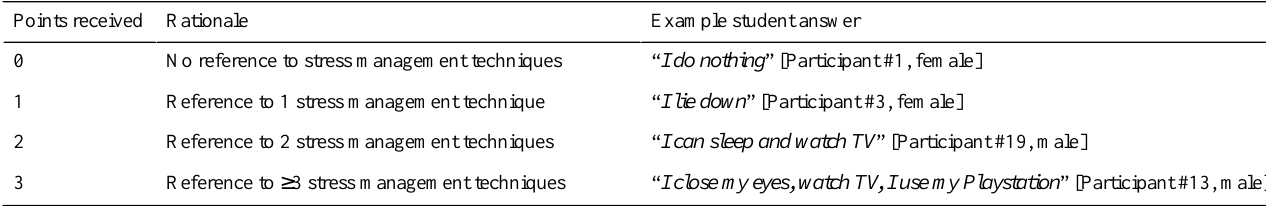
Table 3. Coding sheet for an open-ended question on the identification of stress management